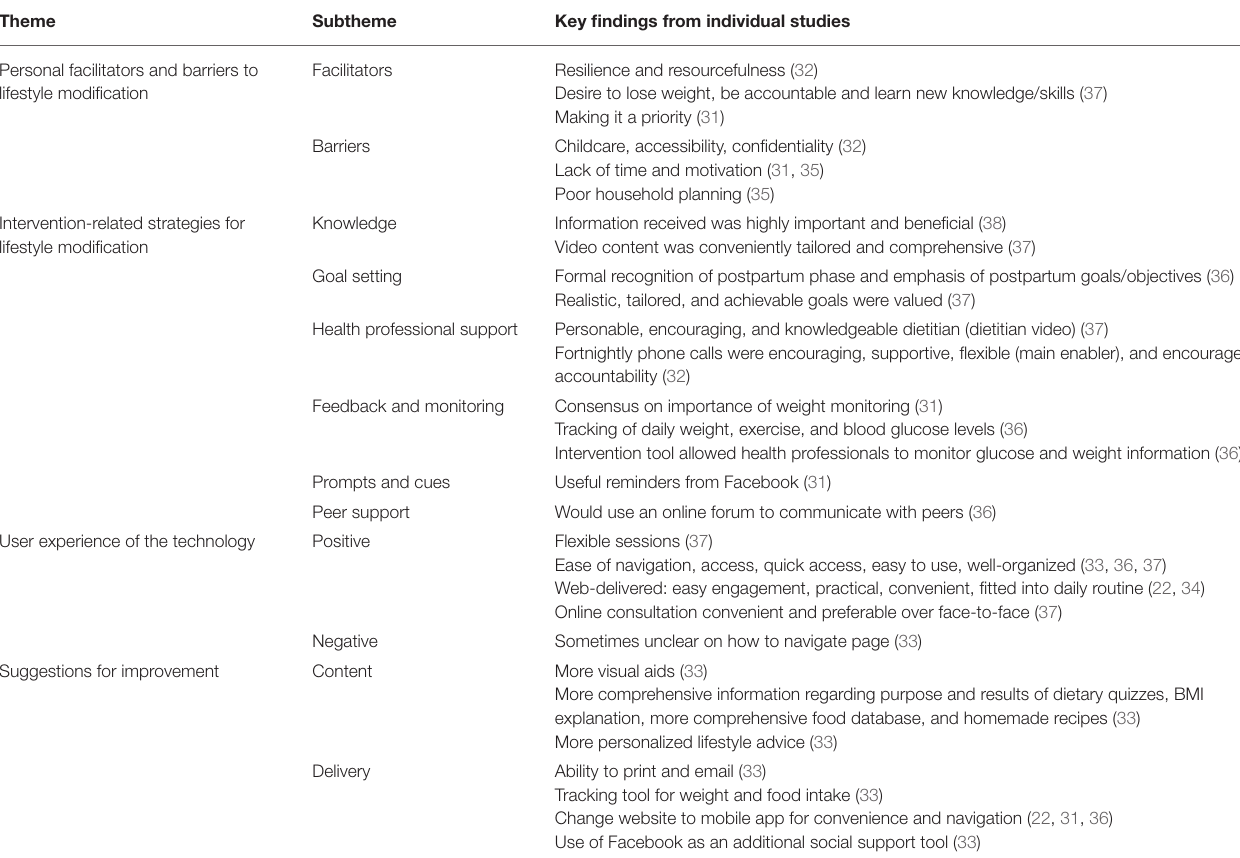
TABLE 3 | Summary of key themes, subthemes, and findings on postpartum women’s perspective on digital health interventions. Theme Subtheme Key findings from individual studies Personal facilitators and barriers to lifestyle